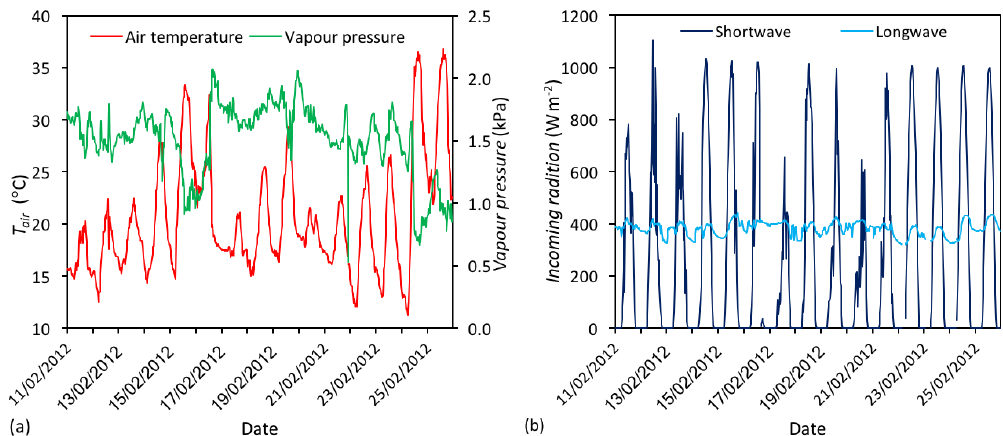
Figure B1. Meteorological conditions during the land cover validation period. Data source: Melbourne Airport Bureau of Meteorology (ID 086282) weather station.